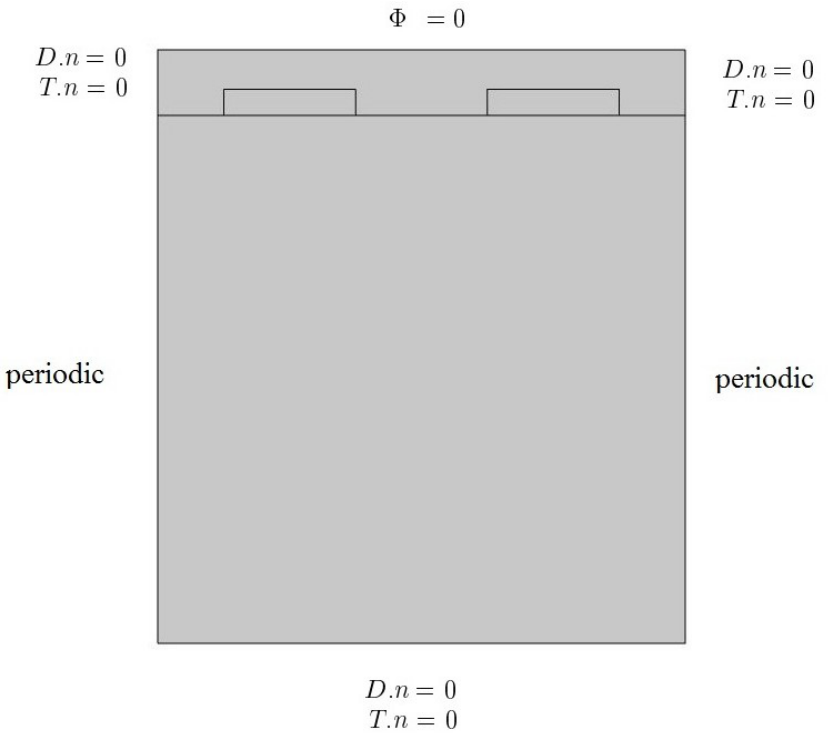
Figure 3. Geometry of the electric part of the proposed SAW unit cell and electrical boundary